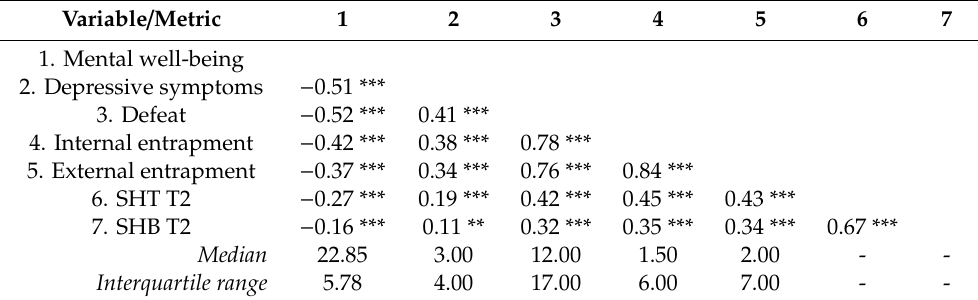
Table 1. Means, standard deviations and Spearman correlational coe ffi cients for mental well-being, depression, defeat, internal entrapment, external entrapment and self-harm thoughts and behaviors. Variable /